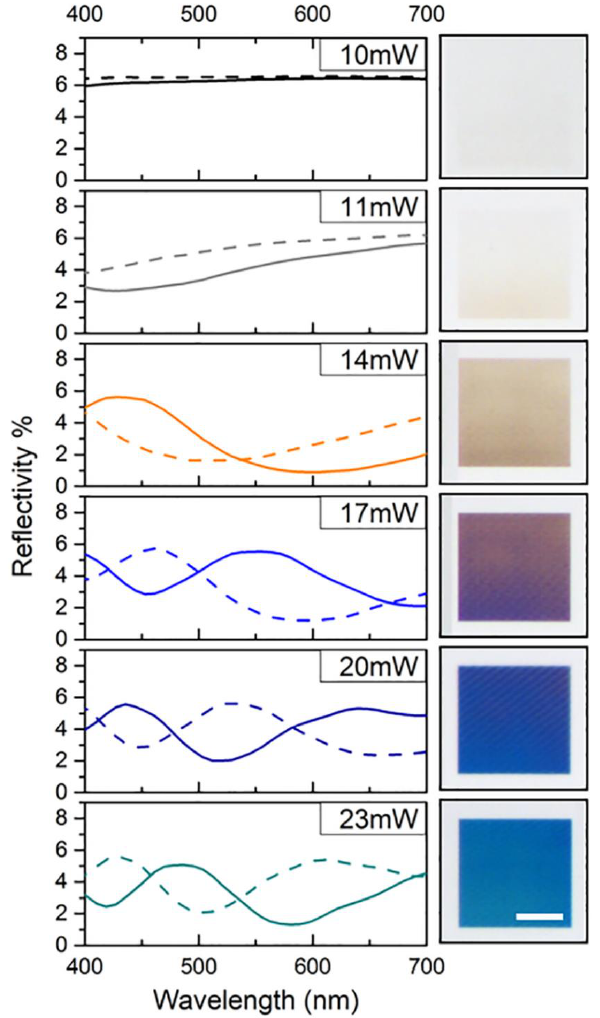
Figure 3. Optical properties of the nanopillar gratings. Reflectivity in dependence on the wavelength obtained from numerical simulations for structure sizes as measured by SEM (solid line) and pillars assuming 20% smaller diameters (dashed line) (left) compared to optical micrographs of nanopillar gratings fabricated with different laser powers (right). The scale bar is 25 µm.